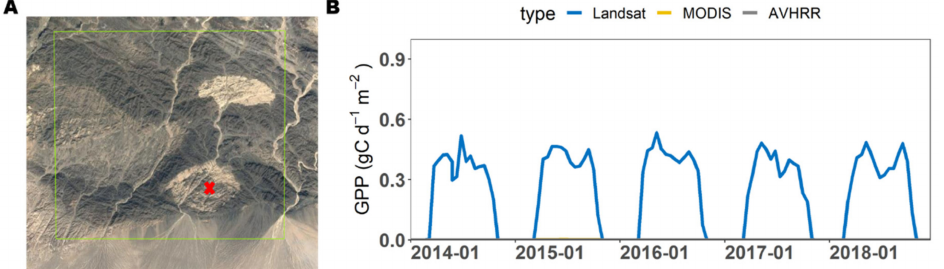
Figure 7. Subplot ( A ) shows an oasis in the desert at Qiancaozi, Xinjiang, China (94.65 ◦ E, 42.63 ◦ N). Subplot ( B ) shows the seasonal change in GPP L , GPP M , and GPP A , while the GPP M and GPP A are close to 0 at the red cross representing an oasis (Figure